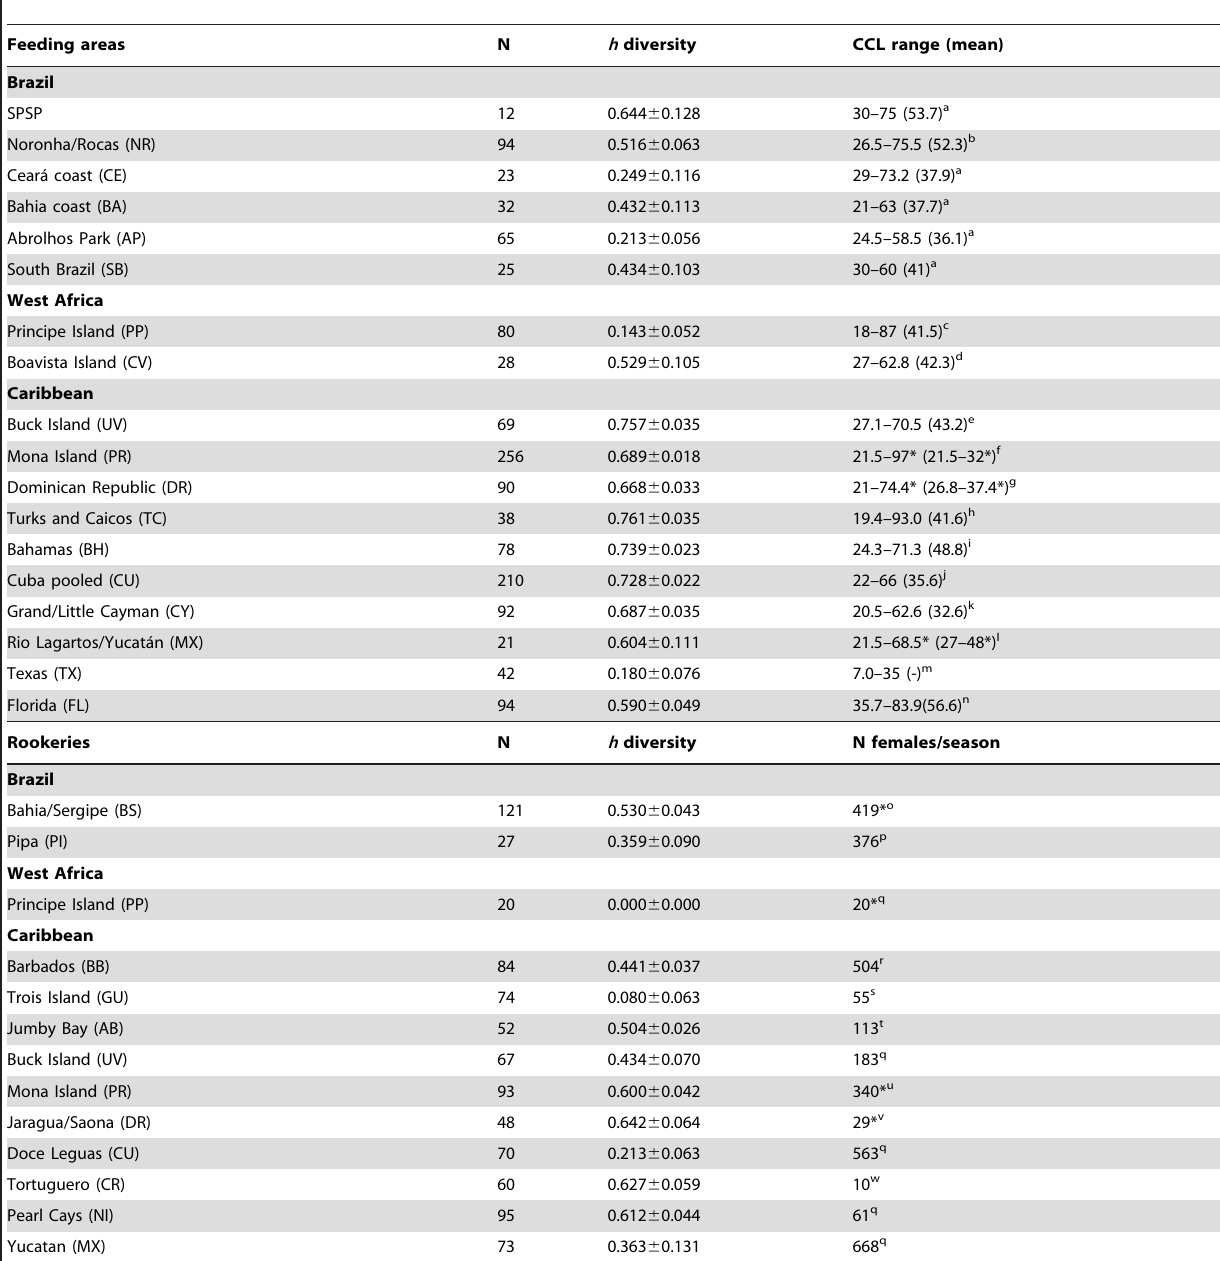
Table 2. Haplotype diversities and biological information of Atlantic E. imbricata populations.